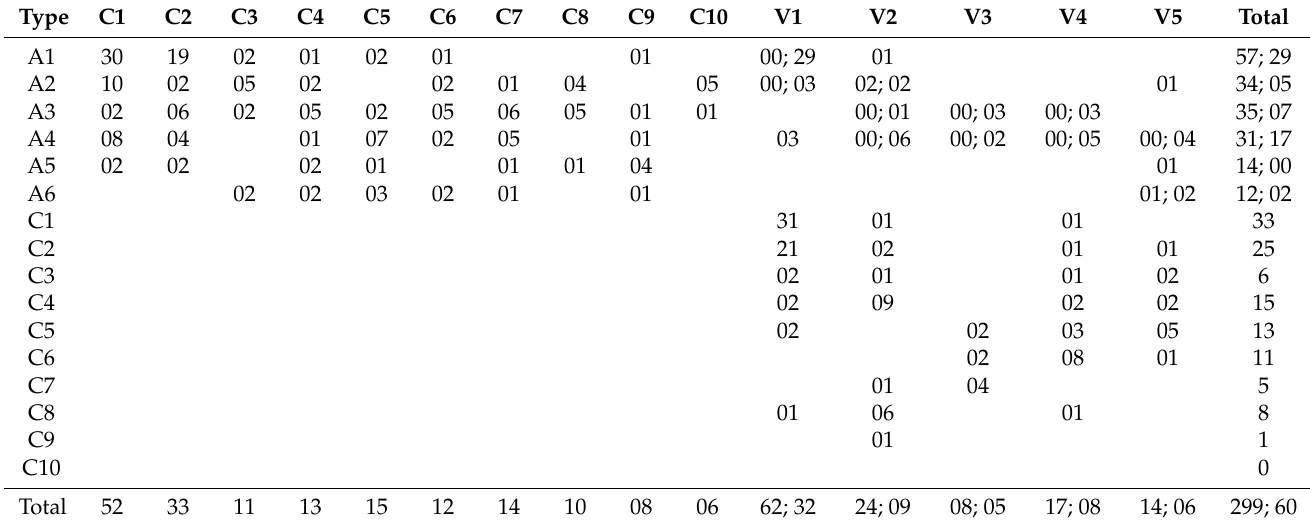
Table 3. The implication matrix for Pok é mon Go users’ experiences in this study (N = 34).